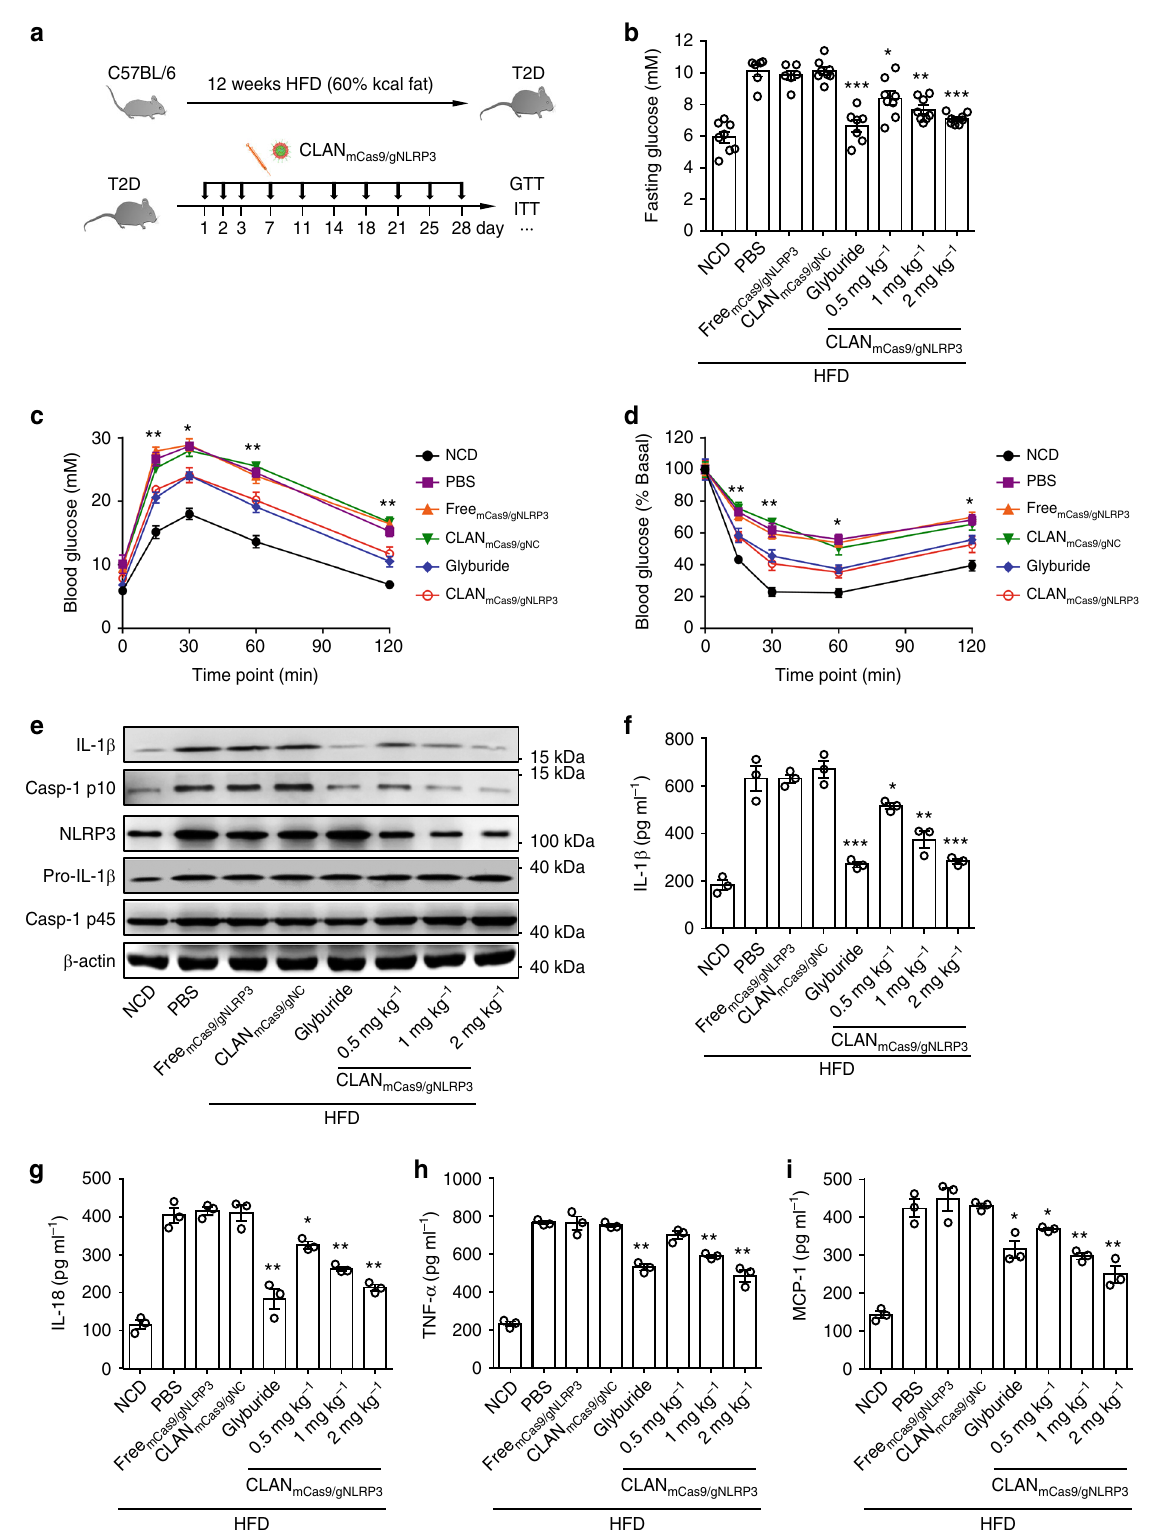
Fig. 7 Treatment of HFD-induced T2D via CLAN mCas9/gNLRP3 -mediated NLRP3 knockout. a Scheme of treatment. Mice fed on a normal chow diet (NCD) were used as a healthy control. b – d Fasting glucose ( b ), GTT ( c ), or ITT ( d ) of T2D mice treated with CLAN mCas9/gNLRP3 or other formulations, see also Supplementary Fig. 13, n = 6 – 8 per group. e Immunoblot analysis of WAT lysates from T2D mice treated with CLAN mCas9/gNLRP3 or other formulations. WAT was collected after GTT and ITT measurement. f – i WAT of T2D mice treated with CLAN mCas9/gNLRP3 or other formulations were cultured for 24 h, and supernatants were analyzed by ELISA to detect IL-1 β ( f ), IL-18 ( g ), TNF- α ( h ), and MCP-1 ( i ) release from WAT. The data are shown as the means ± SEM of n = 6 – 8 ( b – d ) or n = 3 ( f – i ) or are representative of three independent experiments ( e ). Two-way ANOVA ( b – d ), f – i * P < 0.05, ** P < 0.01, *** P <